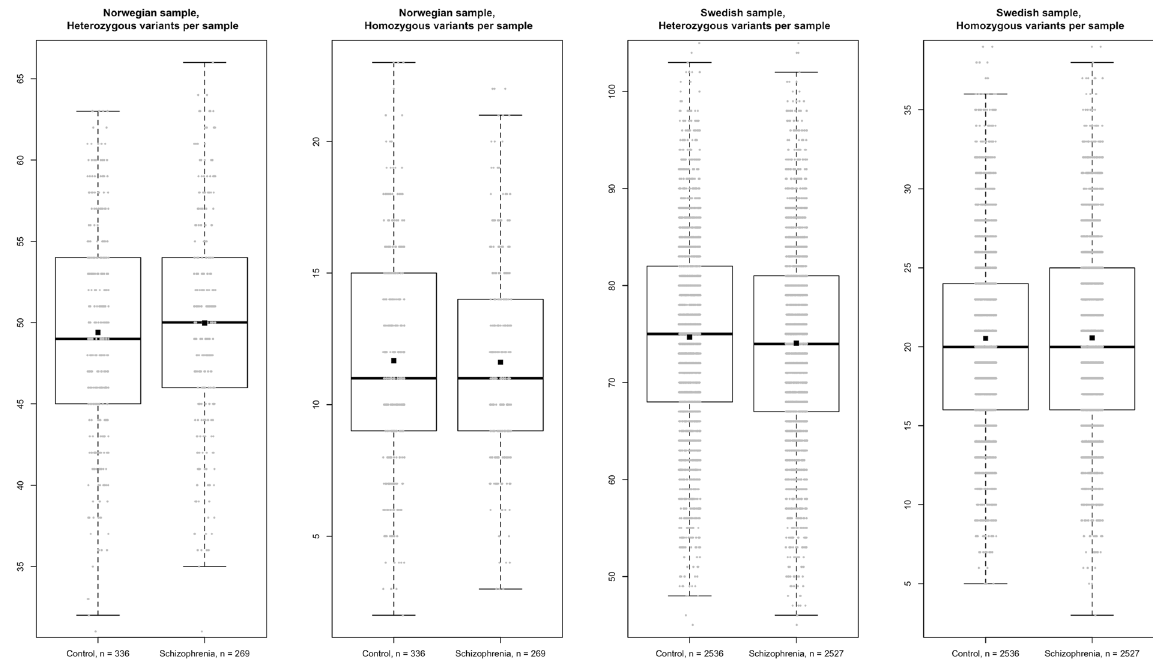
Figure 2. Distributions of heterozygous and homozygous alternative variant counts in Norwegian and Swedish samples. Boxplots represent first quartile, median and third quartile. Mean values are additionally marked with squares. Each grey dot represents number of myelination gene variants in one